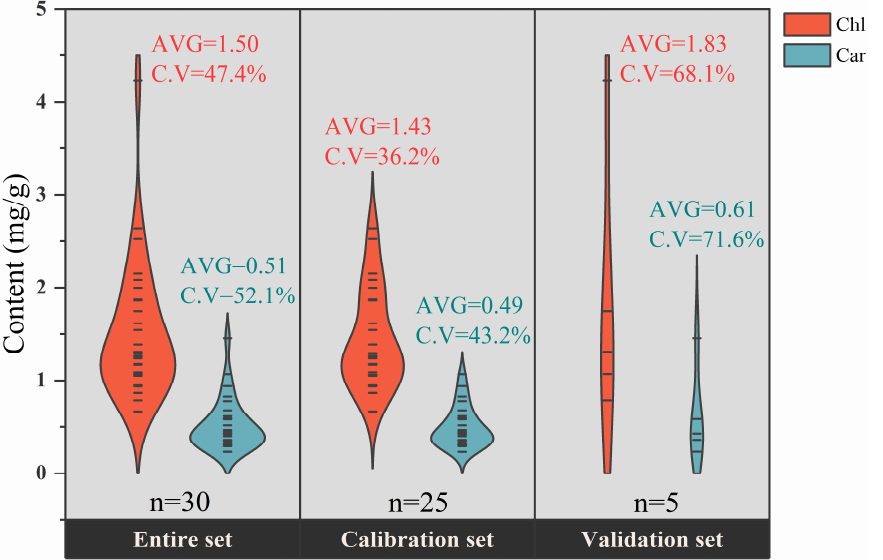
Figure 10. Descriptive statistics violin diagram for model data.